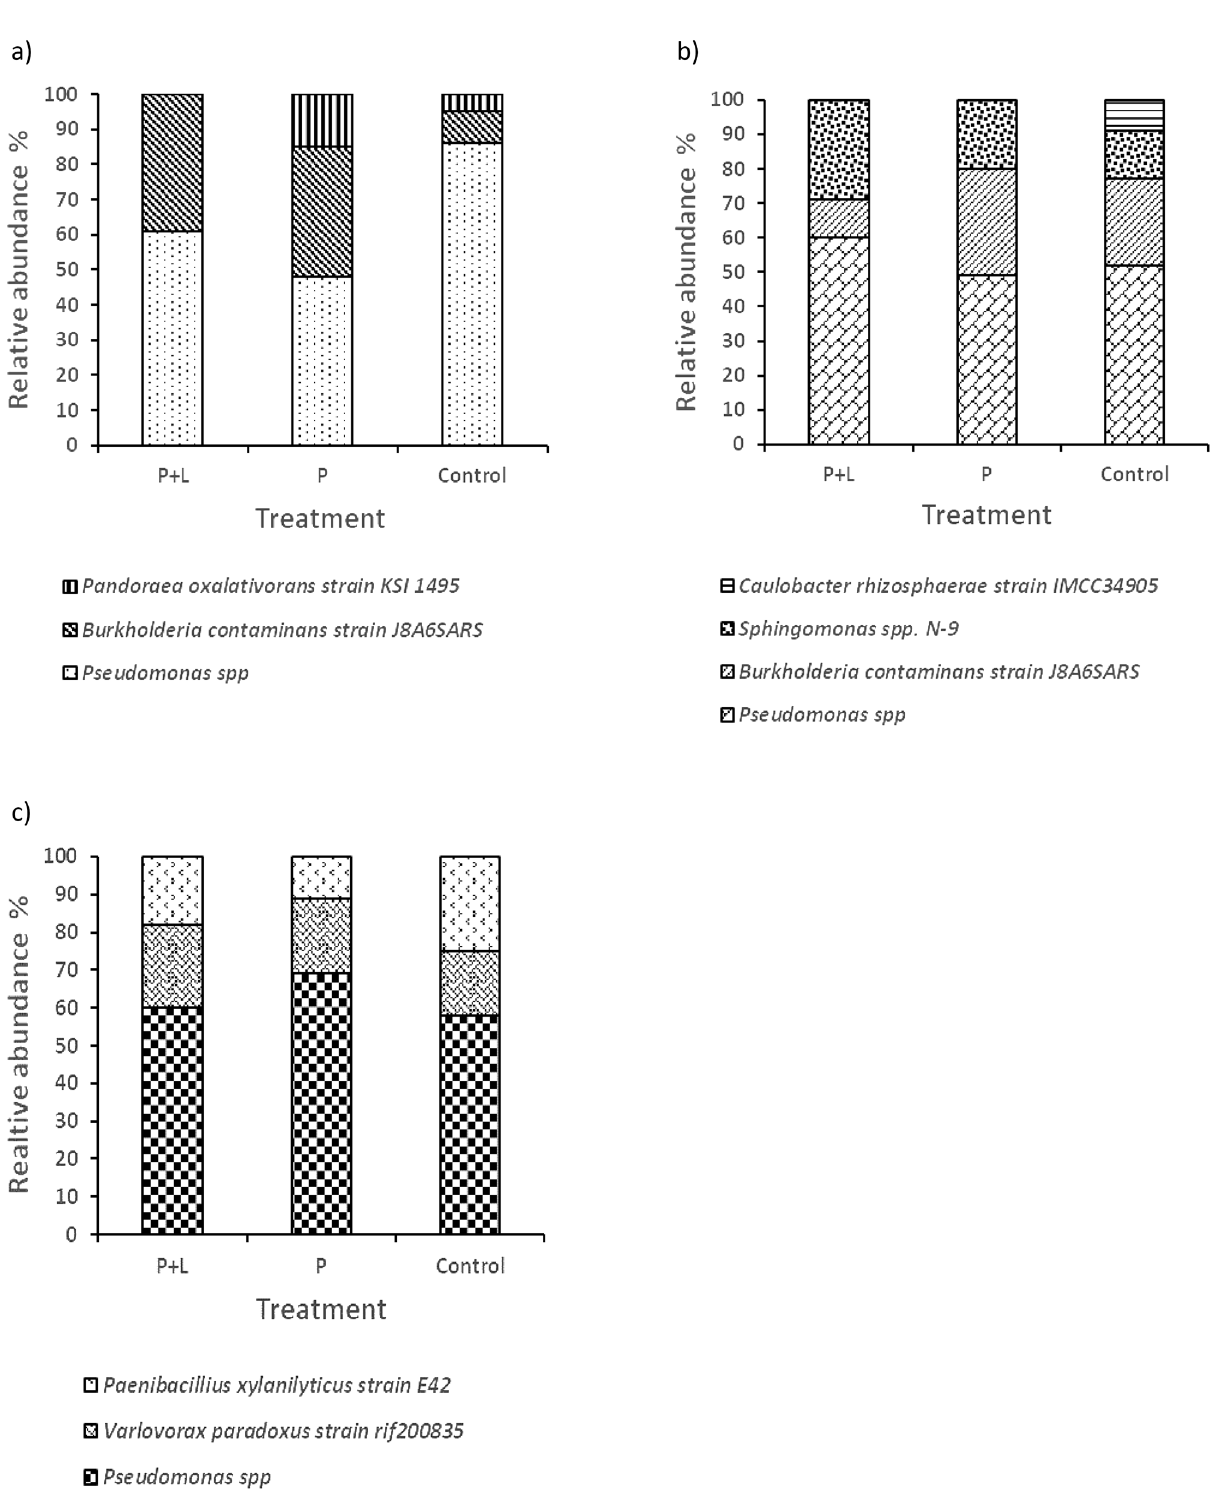
Figure 1. The relative abundance of the microbial communities ( a ) N cycling bacteria, ( b ) N fixing bacteria and ( c ) Phosphate solubilizing bacteria, soils supplemented with phosphorus and lime, soils rich in phosphorus and control soils collected at Ukulinga farm,